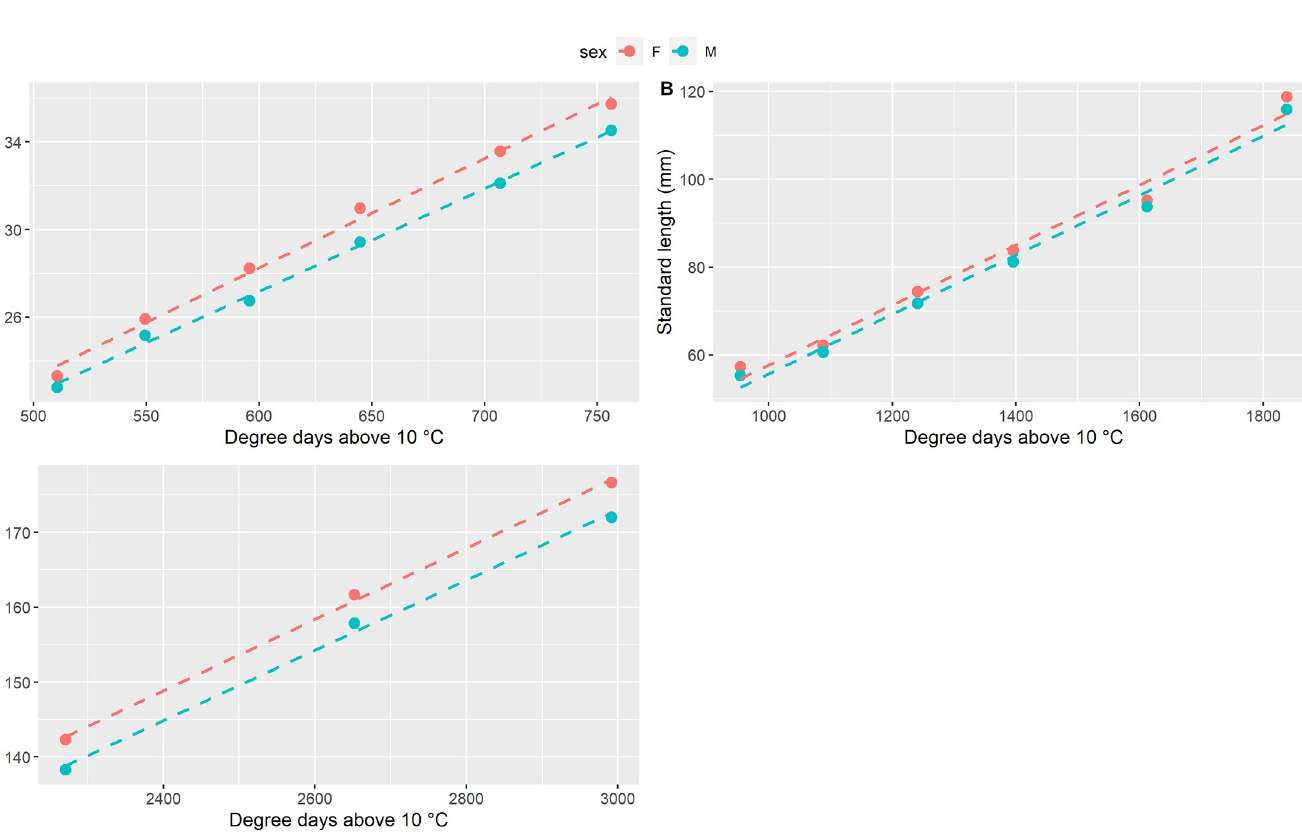
Number and percentage of males and females (N%), mean daily growth coefficient (DGC) ± standard deviation for each age interval. Asterisks indicate significant differences between males and females ( p -value < .01 �� ).